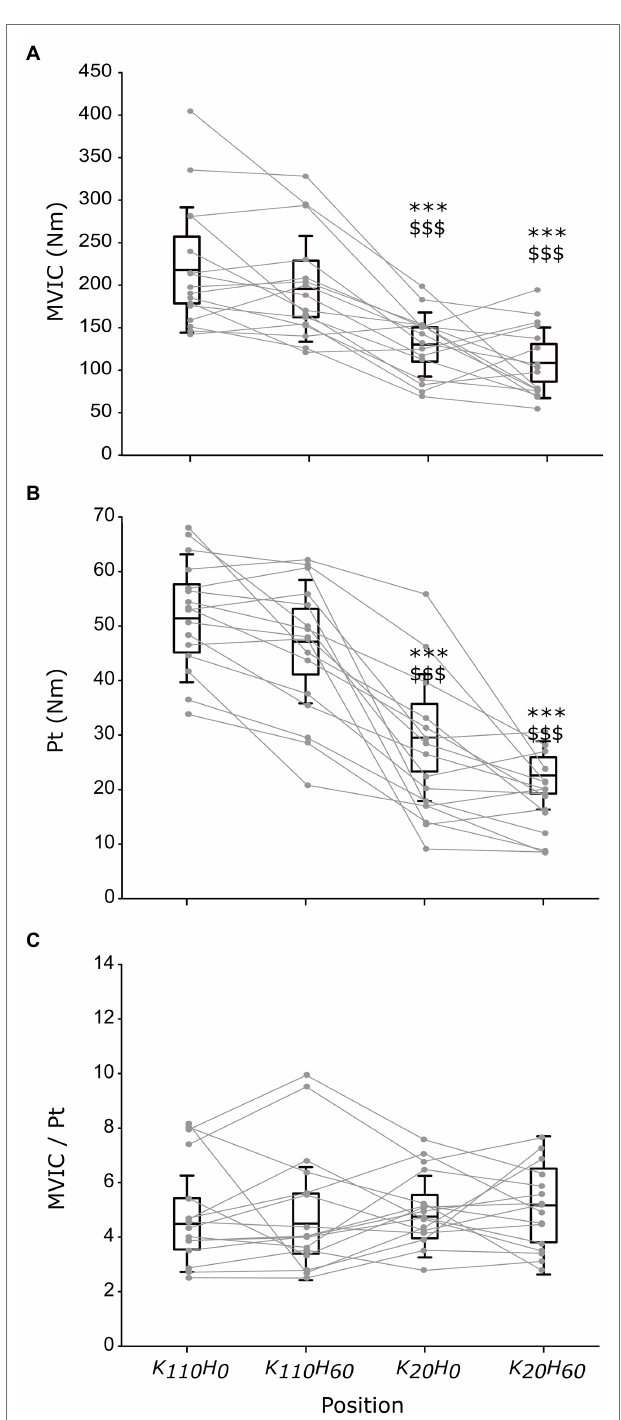
FIGURE 3 | Maximal torque production capacity of the knee extensors measured in each position during maximal voluntary isometric contraction (MVIC; A ) or elicited by percutaneous nerve stimulation (B) , and the ratio between MVIC and peak twitch maximal responses ( C ; n = 16). Black boxes and whisker plots represent the average values for all participants (line: mean, box: 95% CI, and whiskers: SD), individual data are provided in grey. * or $ denotes significant difference from position K 110 H 0 or K 110 H 60 , respectively ( p <